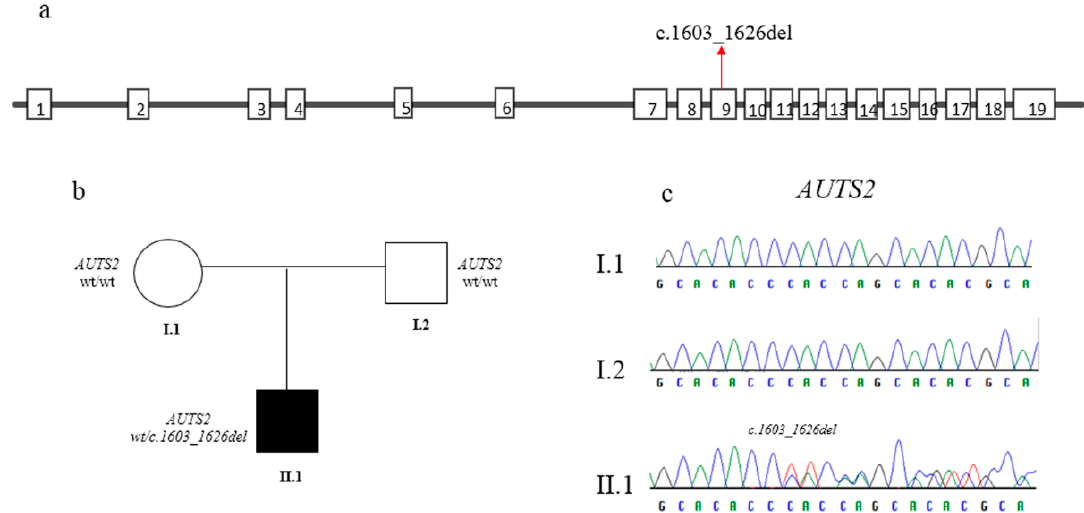
Figure 2. ( a ) Schematic representation of the structure of AUTS2 gene. The variant identified here is indicated by red arrow. ( b ) Pedigree of the family displaying the de novo onset of the variant. Filled and unfilled circles/squares represent affected and unaffected individuals respectively. ( c ) Electropherograms of the proband (II.1) and his parents (I.1, I.2).